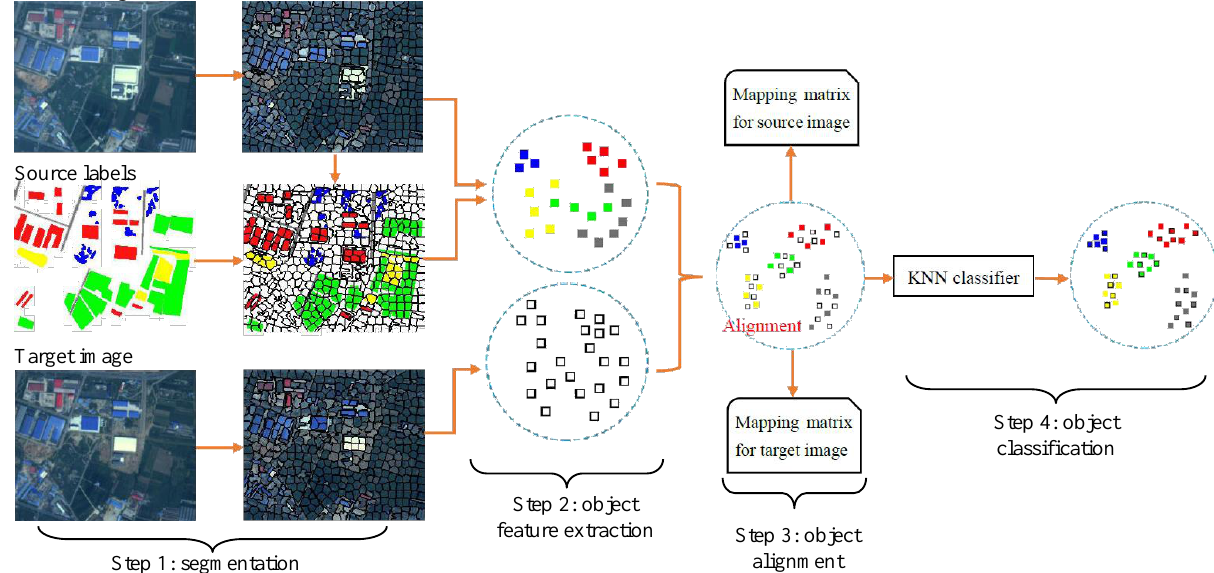
Fig.1 Framework of the proposed multitemporal high resolution images